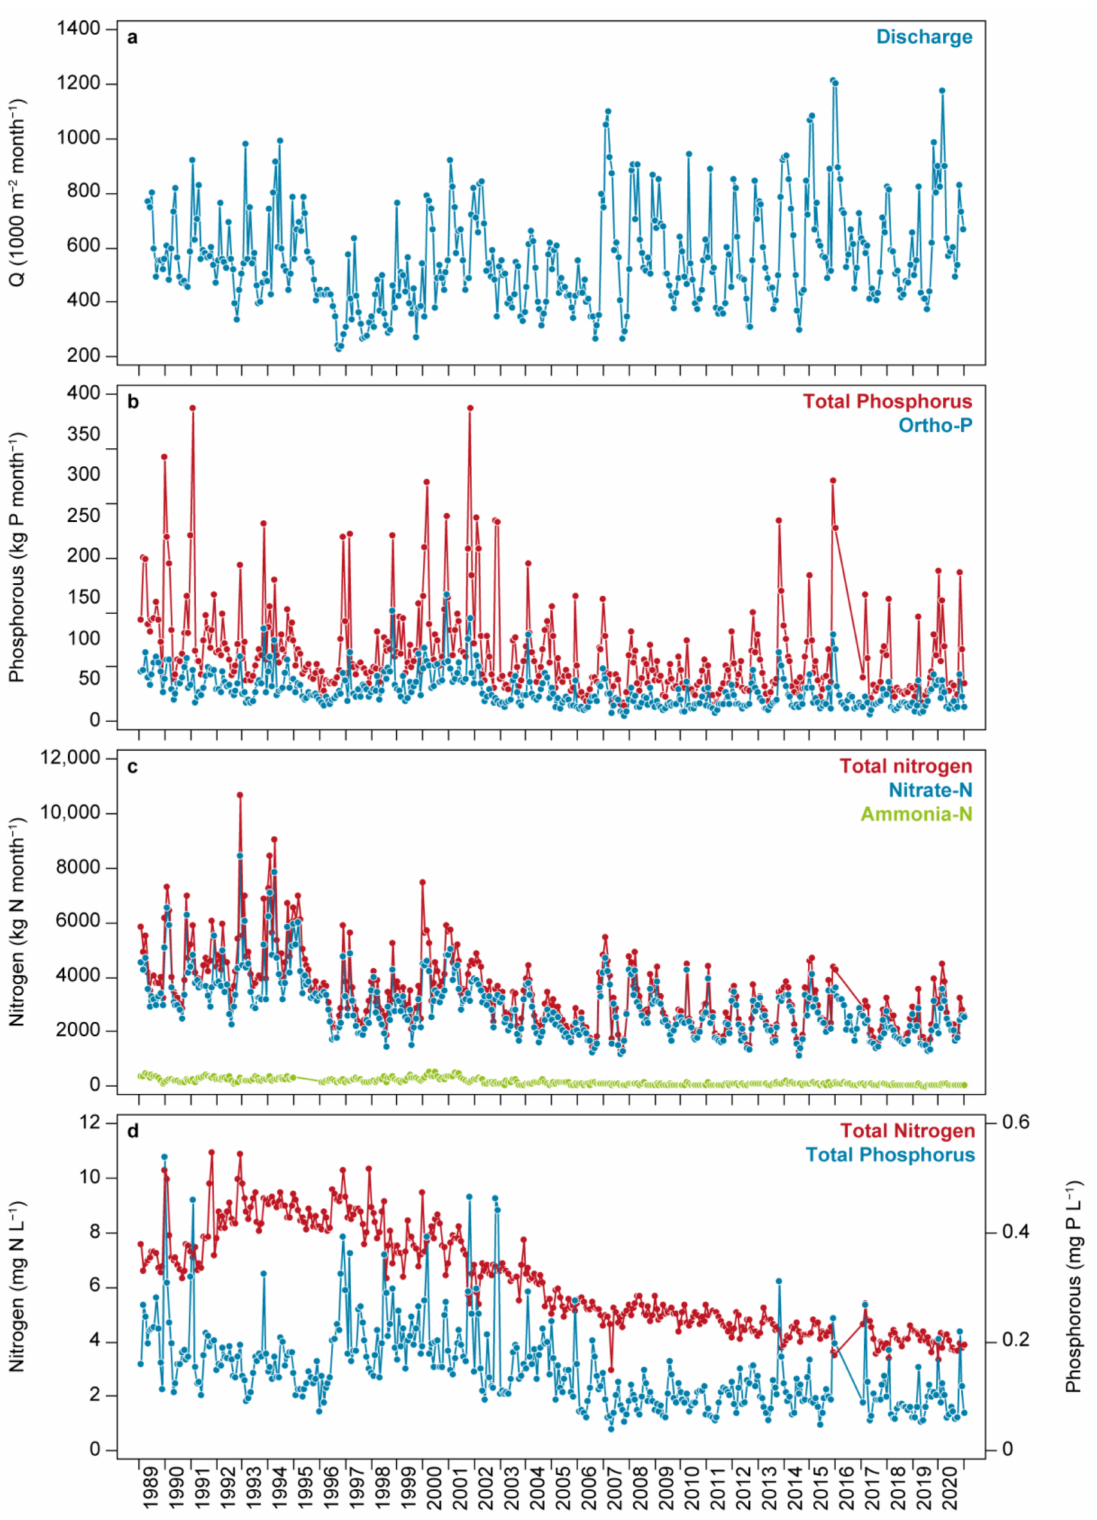
Figure 5. Monthly data for ( a ) monitored inlet (inflow) discharge; ( b ) loading of total phosphorus and ortho-phosphate-P; ( c ) loading of total nitrogen, nitrate-N, and ammonium-N; and ( d ) discharge weighted inlet concentration of total phosphorus and nitrogen in one of the two main inlets (Bredkær Bæk) to Lake Kilen from 1989 to 2019. This inlet accounts for about 48% of the total freshwater input to the